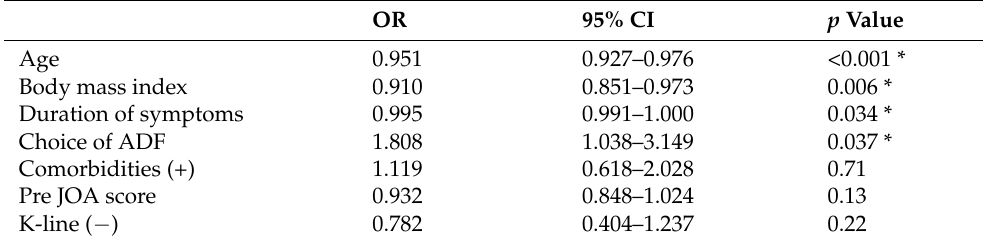
Table 4. Factors affecting MCID